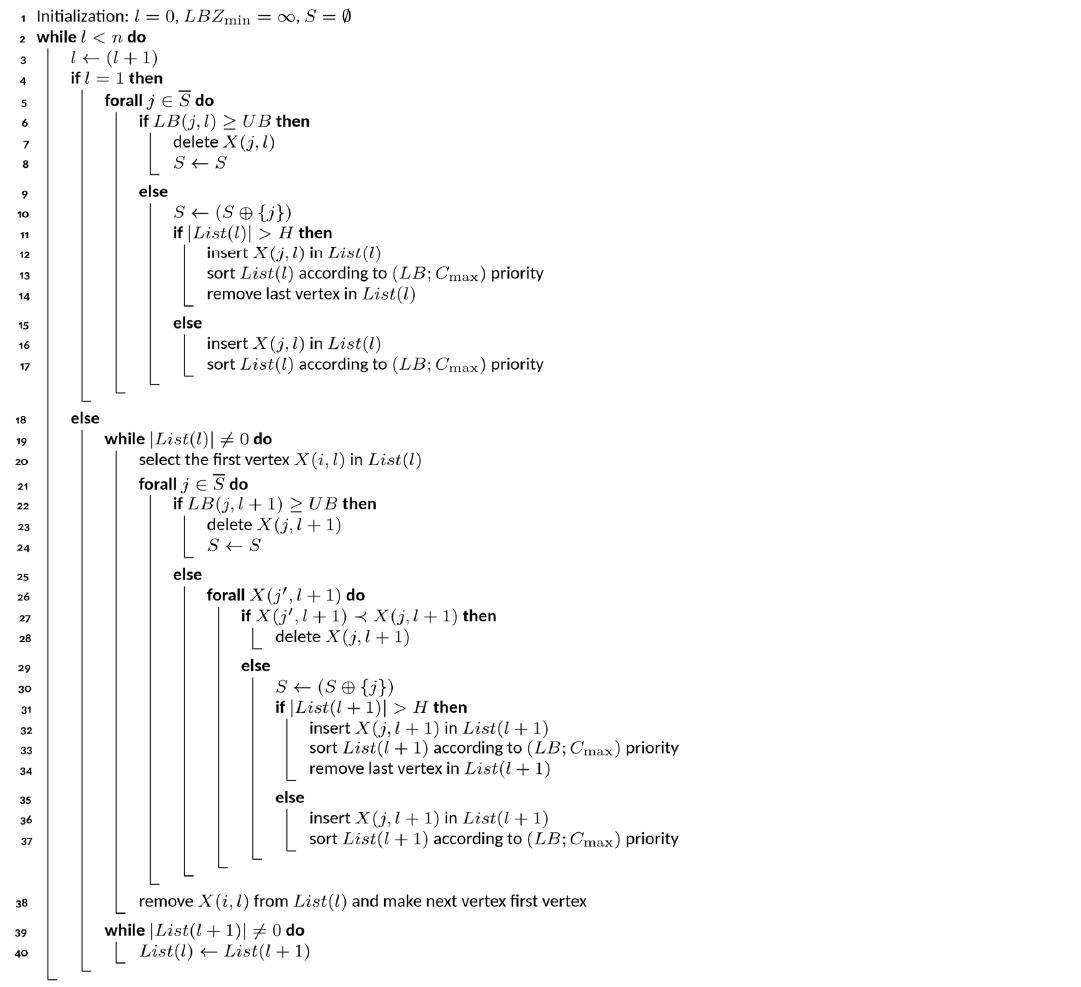
Fig. 4. BDP algorithm for the 𝐹𝑚 | 𝑠